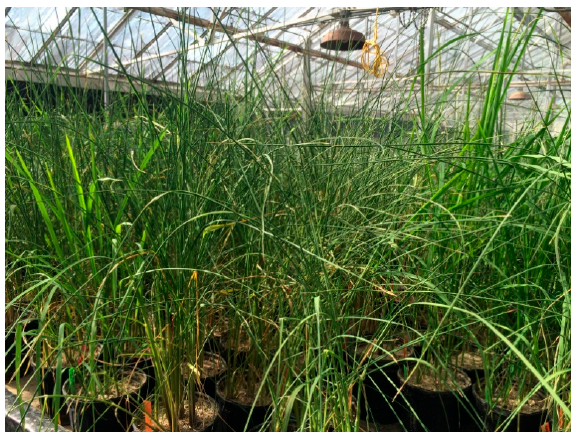
Figure 1. F 2:3 progenies derived from Cocodrie × Nagina 22 (N22) showing segregation for drought response phenotypes under greenhouse conditions.